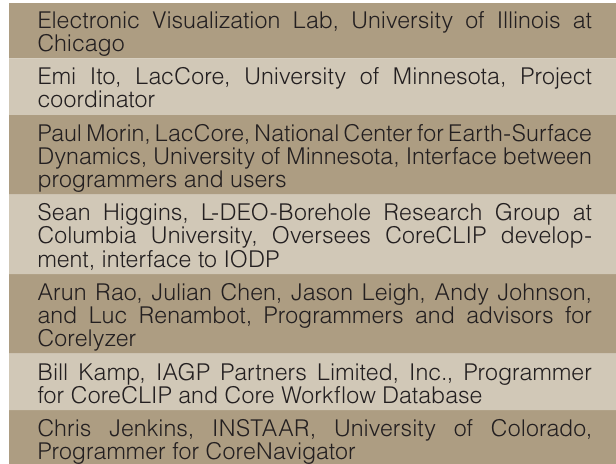
Table 1. Developers of CoreWall